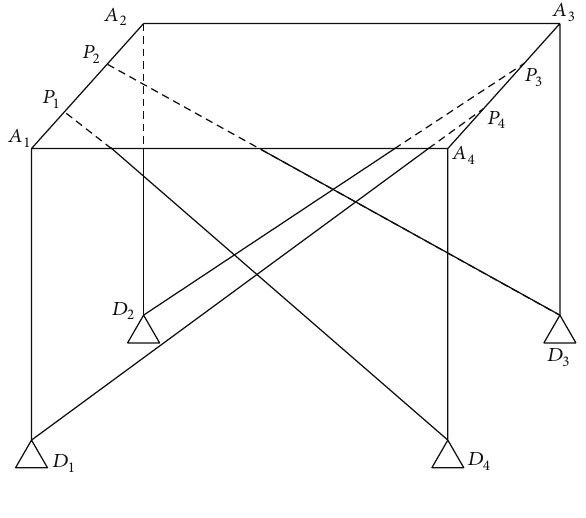
Figure 1: Platform